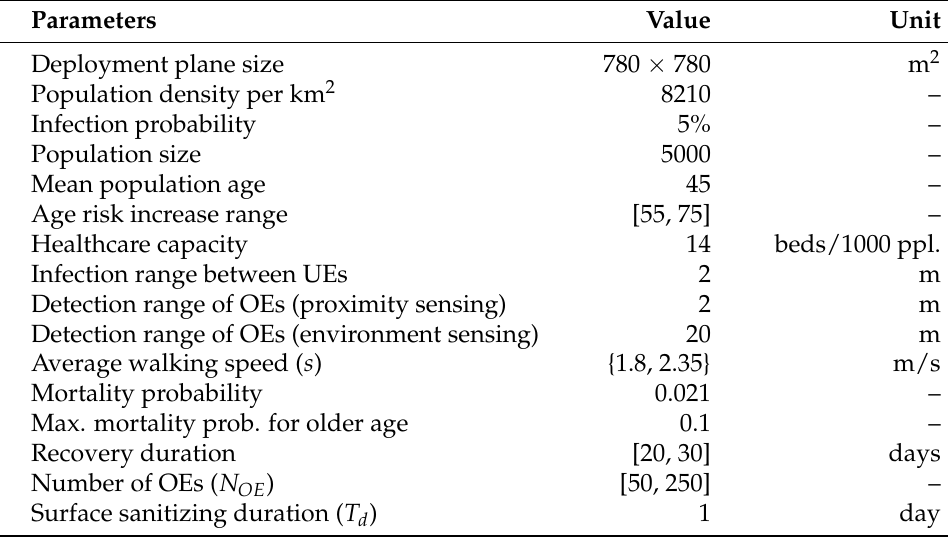
Table 2. Simulation